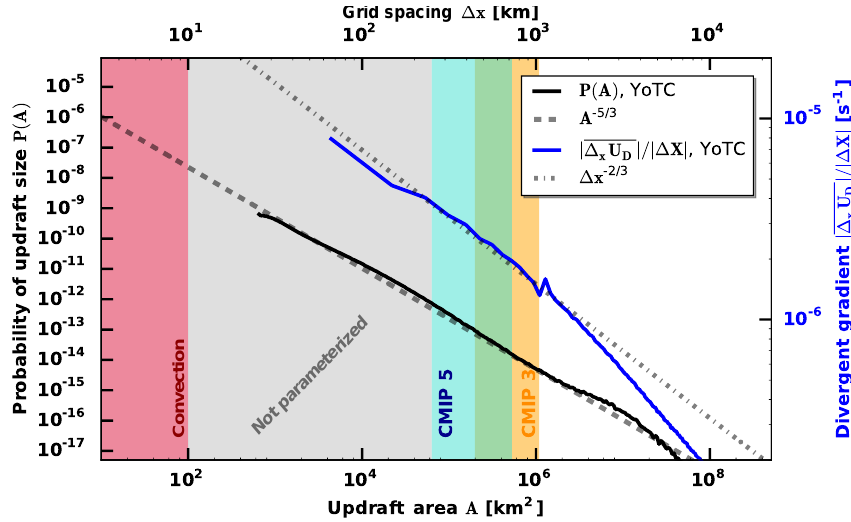
Figure 3. Probability distribution of updraft area P(A) (black curve; left axis) and the structure function of the zonal, divergent wind component | (cid:49) x U D | divided by the structure function distance (cid:49)x (blue curve; right axis). Both P(A) and the structure function are derived from 1.5 years of 500hPa output from the ECMWF Year of Tropical Convection (YoTC) T799 operational forecast output (European Centre for Medium-Range Weather Forecasts, 2012). The shaded golden and blue regions correspond to the inter-quartile range of CMIP3 and CMIP5 models, respectively, and the shaded rose region corresponds to the scales at which convection occurs. A − 5 / 3 and (cid:49)x − 2 / 3 power laws are provided for reference (gray dashed and gray dash-dotted lines,